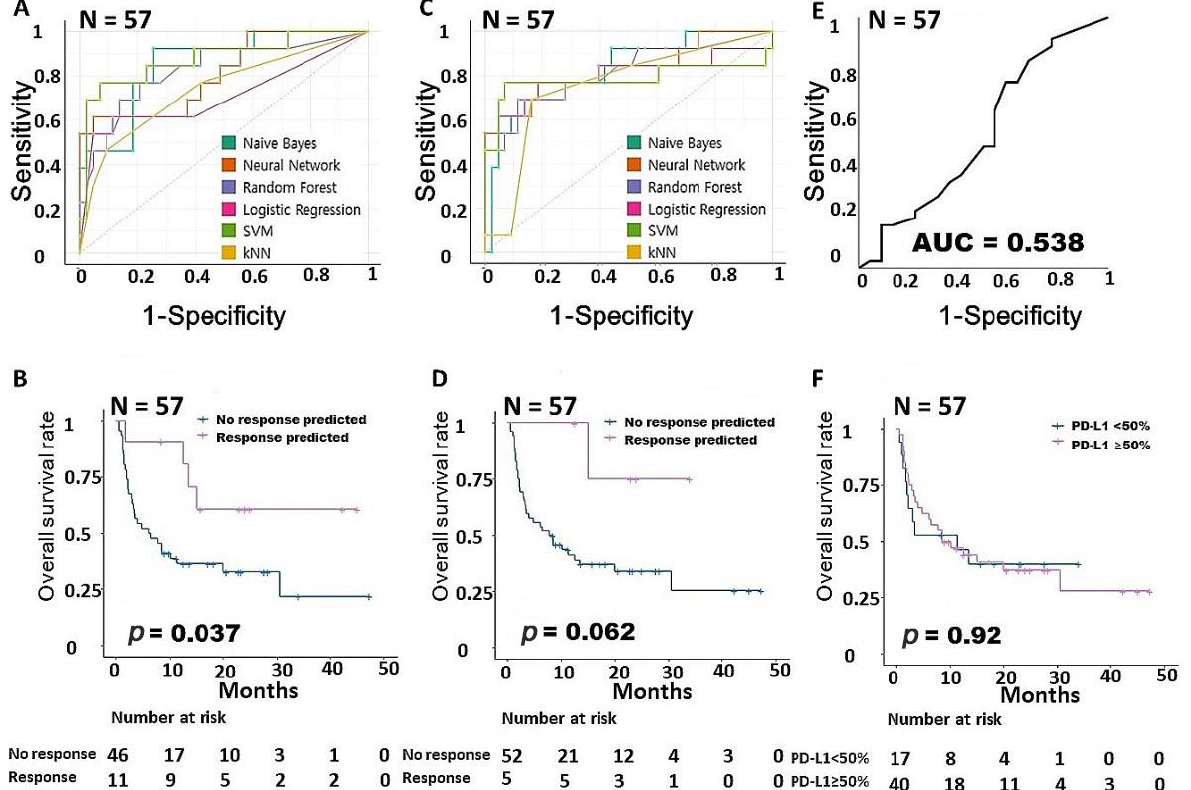
Figure 1. Building a predictive model for responsiveness to PD-1 inhibitors in NSCLC. ( A ) Comparison of the AUCs for the intrinsic gene signature according to six machine learning models. ( B ) Survival analysis according to the intrinsic gene signature. ( C ) Comparison of the AUCs for the extrinsic gene signature according to six machine learning models. ( D ) Survival analysis according to the extrinsic gene signature. ( E ) AUC according to PD-L1 expression. ( F ) Survival analysis according to PD-L1 expression. AUC, area under the ROC curve; NSCLC, non – small cell lung cancer; PD-1, programmed cell death protein 1; PD-L1, programmed cell death-ligand 1.